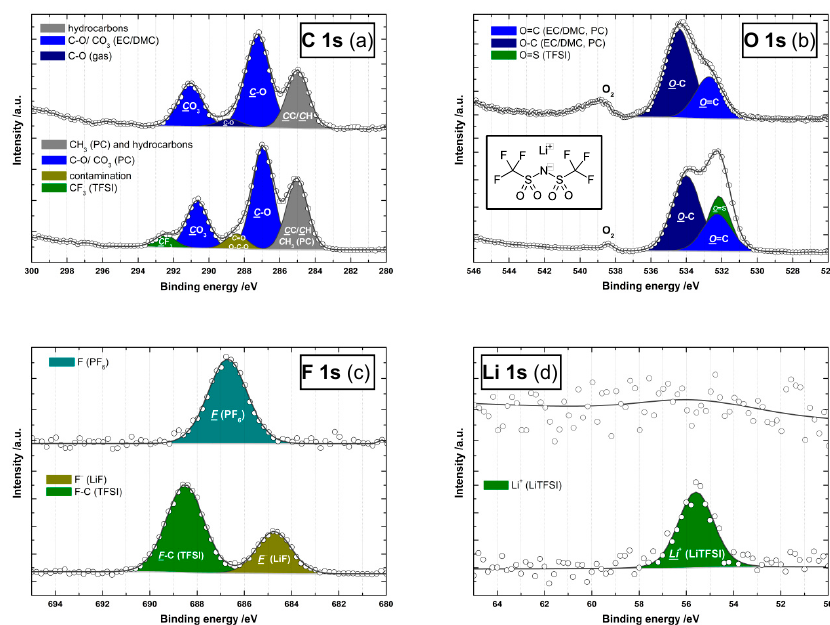
Figure 4. C 1s ( a ), O 1s ( b ), F 1s ( c ), and Li 1s ( d ) core-level spectra of LiPF 6 in EC/DMC (upper curves) at 10 mbar and of LiTFSI in PC (lower curves) at 2 mbar. The chemical structure of LiTFSI is shown in the inset of 4b.